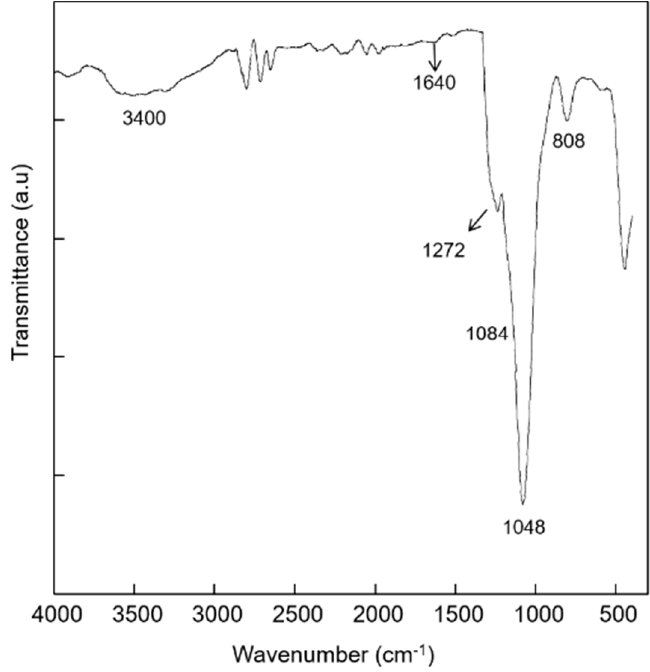
Figure 2. FTIR spectra of the SiO 2 particles for coating aged for 5 days.